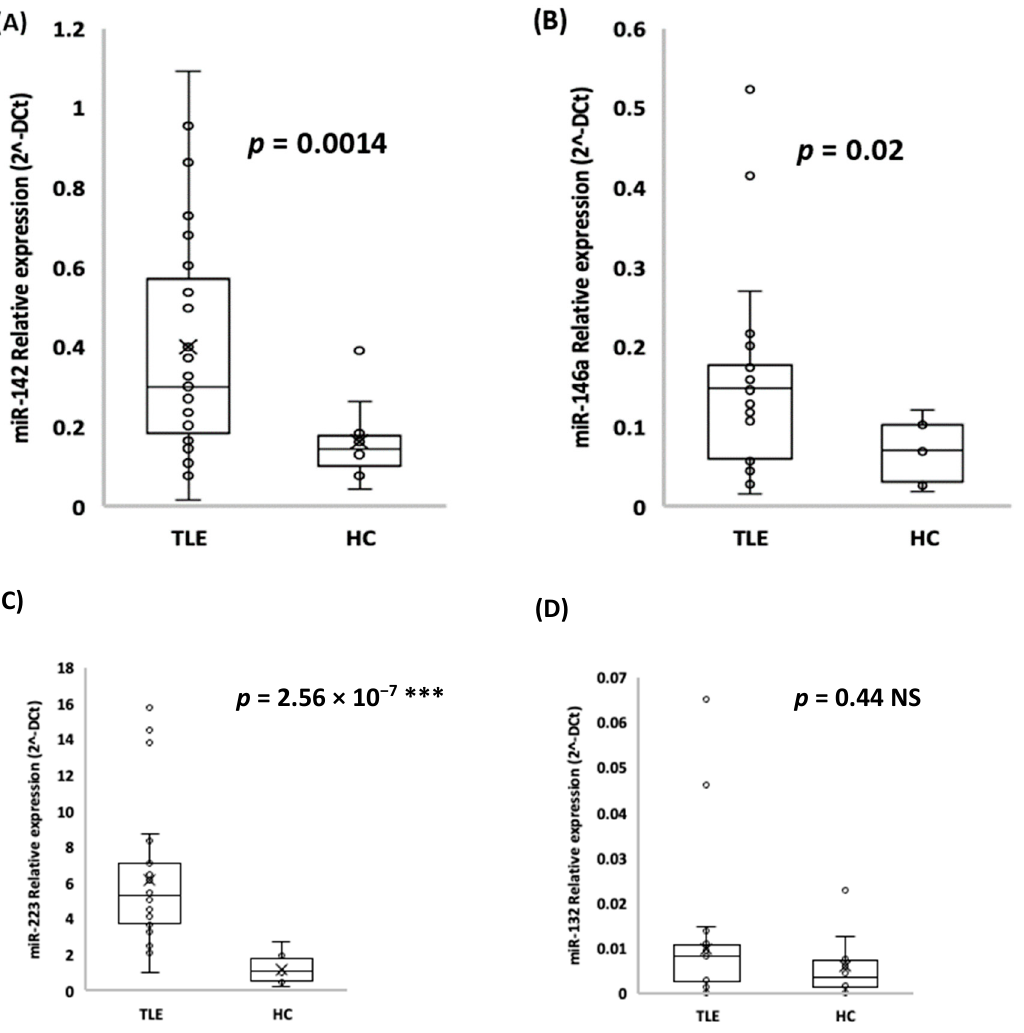
Figure 1. miR-142 ( A ), miR-146a ( B ), miR-223 ( C ), and miR-132 ( D ) relative expression in the TLE patients compared to healthy control (HC) subjects (average of expression ± standard deviation (SD); t -test, *** p -value <